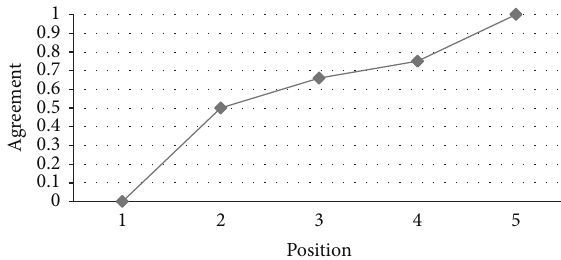
Figure 12: Agreement between the IPA and HAM rankings of nonfunctional